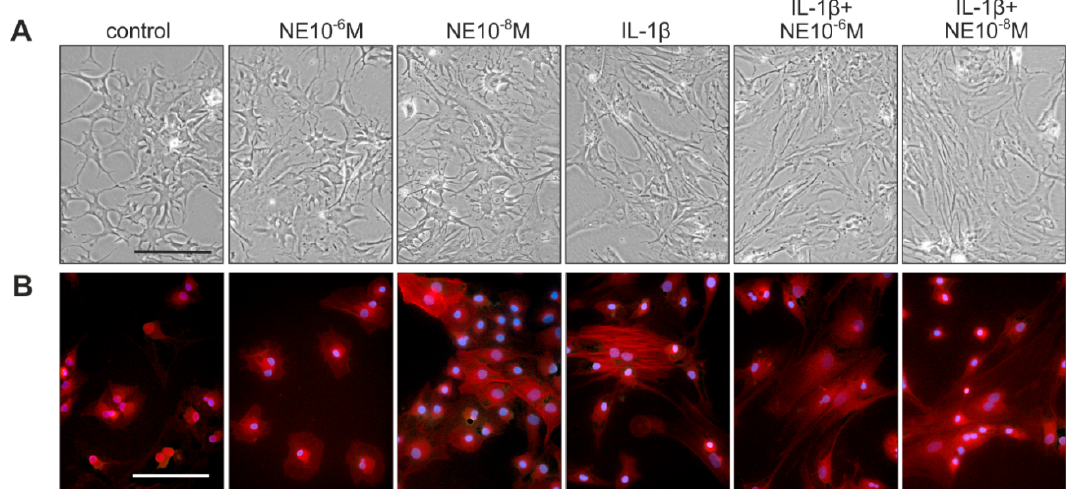
Figure 4. Effects of NE and IL-1 β on chondrocyte morphology and cytoskeleton organization. ( A ) Phase contrast microscopic appearance of OA chondrocytes at day 7 after treatment with NE, IL-1 β , or NE + IL-1 β (representative images of cells isolated form one OA patient, magnification 200×). ( B ) Phalloidin staining of the actin cytoskeleton at day 7 after treatment with NE, IL-1 β , or NE + IL-1 β (representative images of cells isolated form one OA patient, magnification 200 × , red: actin, blue: nuclei). Scale bars represent 100 μ m.